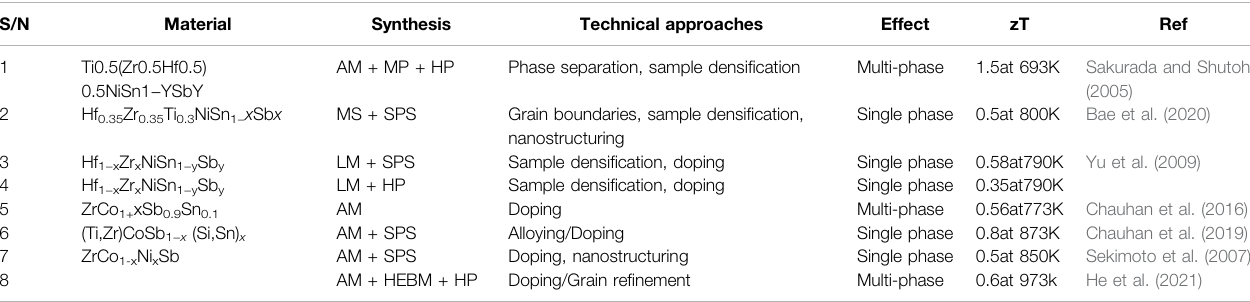
TABLE 2 | Processing methods make a difference to the